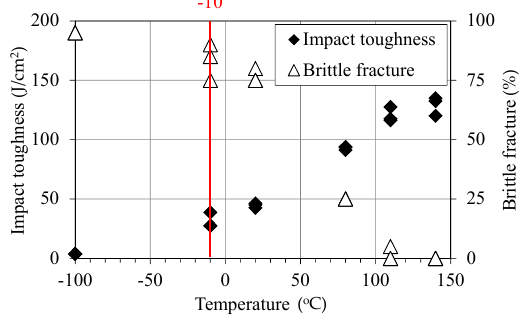
Figure 8. Charpy test results for S45C. The reference temperature of − 10 °C was selected for performing fracture toughness tests in the ductile-to-brittle transition temperature (DBTT) region. Table 3. Chemical compositions of the S45C test specimens in weight %.